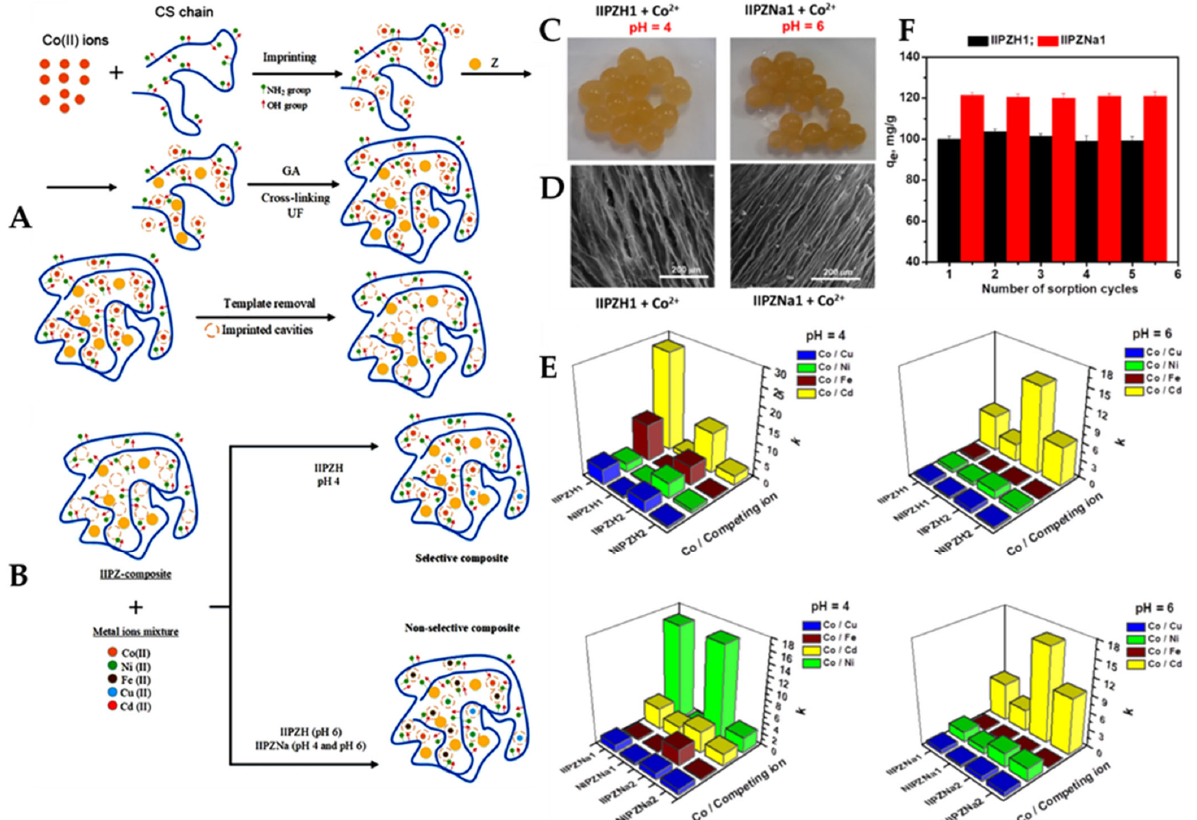
Figure 10. ( A ) The preparation strategy of Co(II)-imprinted CS/zeolite cryo-composites and removal of template ions with ethylenediaminetetraacetic acid disodium salt dihydrate (Na 2 EDTA). ( B ) Selectivity mechanism of Co(II)-imprinted CS/zeolite cryo-composites at pH 4 and pH 6 (ion-imprinted composites = IIPZH and IIPZNa, non-imprinted composites = NIPZ and NIPNa; zeolites (Z1, Z2) converted into the H + or Na + form; Z1 = 60–70 wt% clinoptilolite, Z2 = 82–86 wt% clinoptilolite). ( C ) Optical images of IIPZH1 and IIPZNa1 composites loaded with Co(II) ions at pH 4 and pH 6. ( D ) SEM micrographs of IIPZH1 and IIPZNa1 sorbents loaded with Co(II) ions. ( E ) Selective sorption of Co(II) ions from their five-component mixtures onto the composite cryo-beads. ( F ) The reusability performance of IIPZH1 and IIPZNa1 sorbents after five consecutive sorption–desorption cycles. (Reproduced with permission from Ref. [100]. Copyright 2020